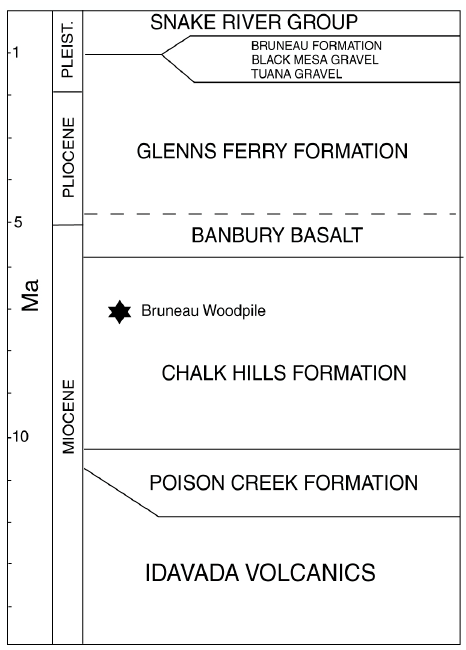
Figure 2. Generalized Stratigraphic Section [2].